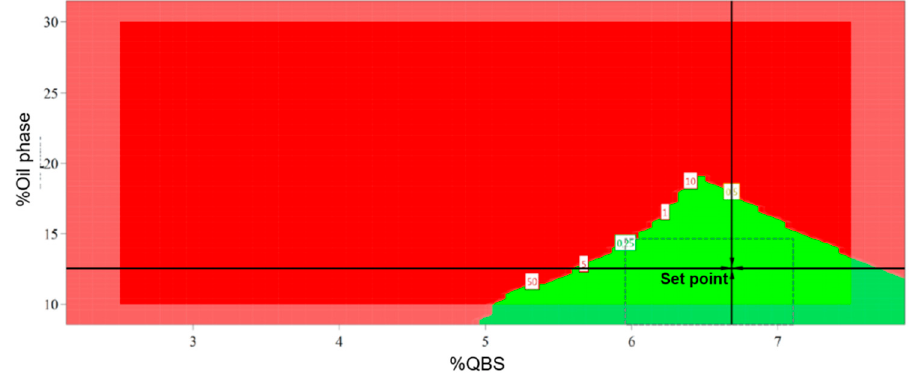
Figure 4. Plot evidence the design space for the QSB-based emulsion.